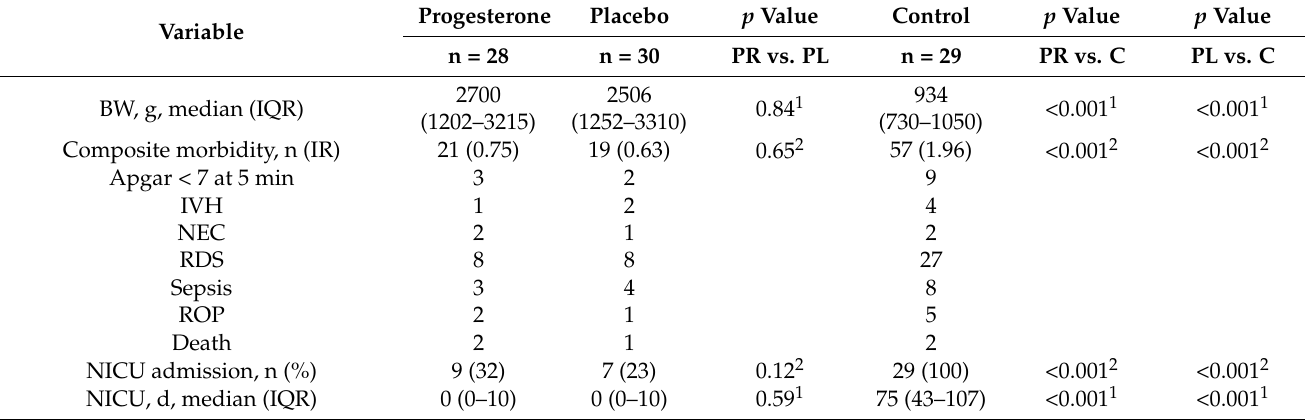
Table 3. Neonatal outcome. Statistical methods: Mann–Whitney U-test and one-way ANOVA 1 ; Chi 2 -test and Fisher’s exact test 2